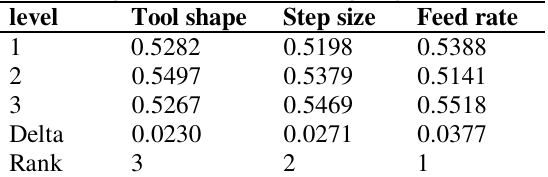
Means larger results (55 ◦ forming angle).